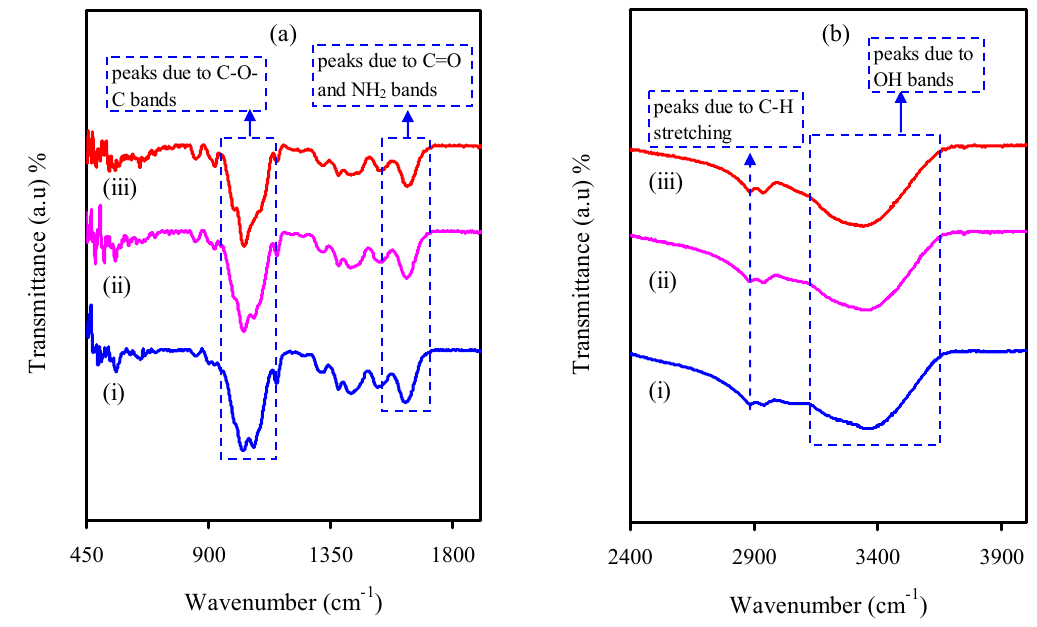
Figure 4. Spectra of (i) CSNZG1, (ii) CSNZG2, and (iii) CSNZG3 electrolyte films in the range ( a ) 450 to 1900 cm –1 and ( b ) 2400 to 4000 cm –1 .